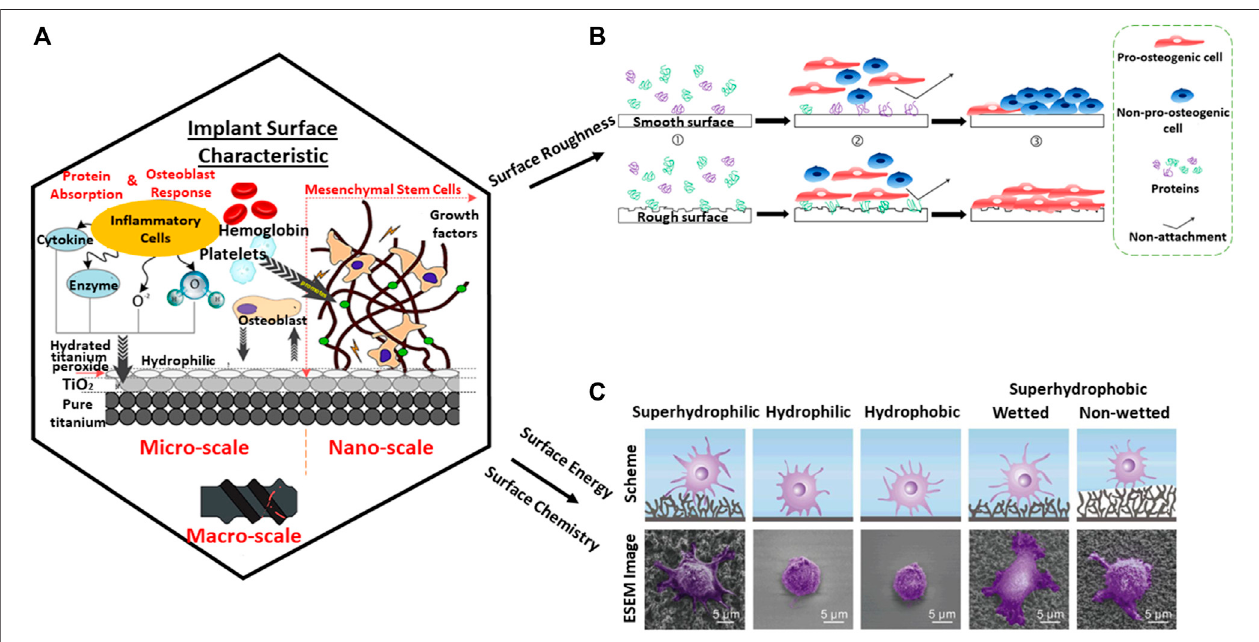
FIGURE5| Proteinadsorptiononthesubstratefrom (A) nano-to-macrolevelwhichisdependentonseveralfactors. (B) Surfaceroughness(Stichetal.,2021). (C) Surface chemistry and surface energy (Meng et al., 2017). Diagram adapted and adjusted from Alipal et al. (2021).